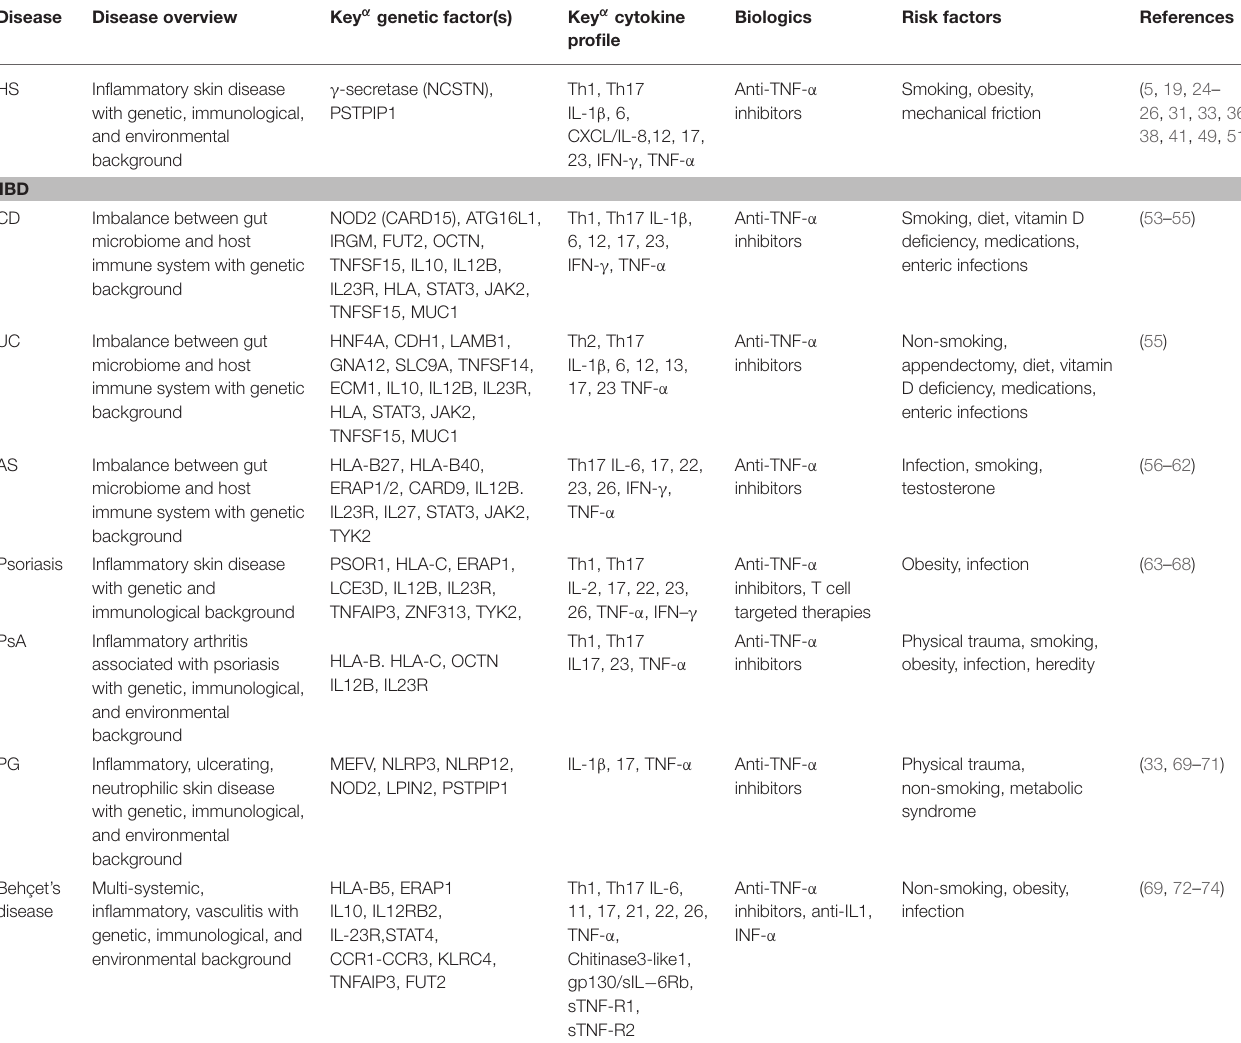
TABLE 2 | Pathogenesis of established immune mediated inflammatory diseases in relation to hidradenitis suppurativa. Disease Disease